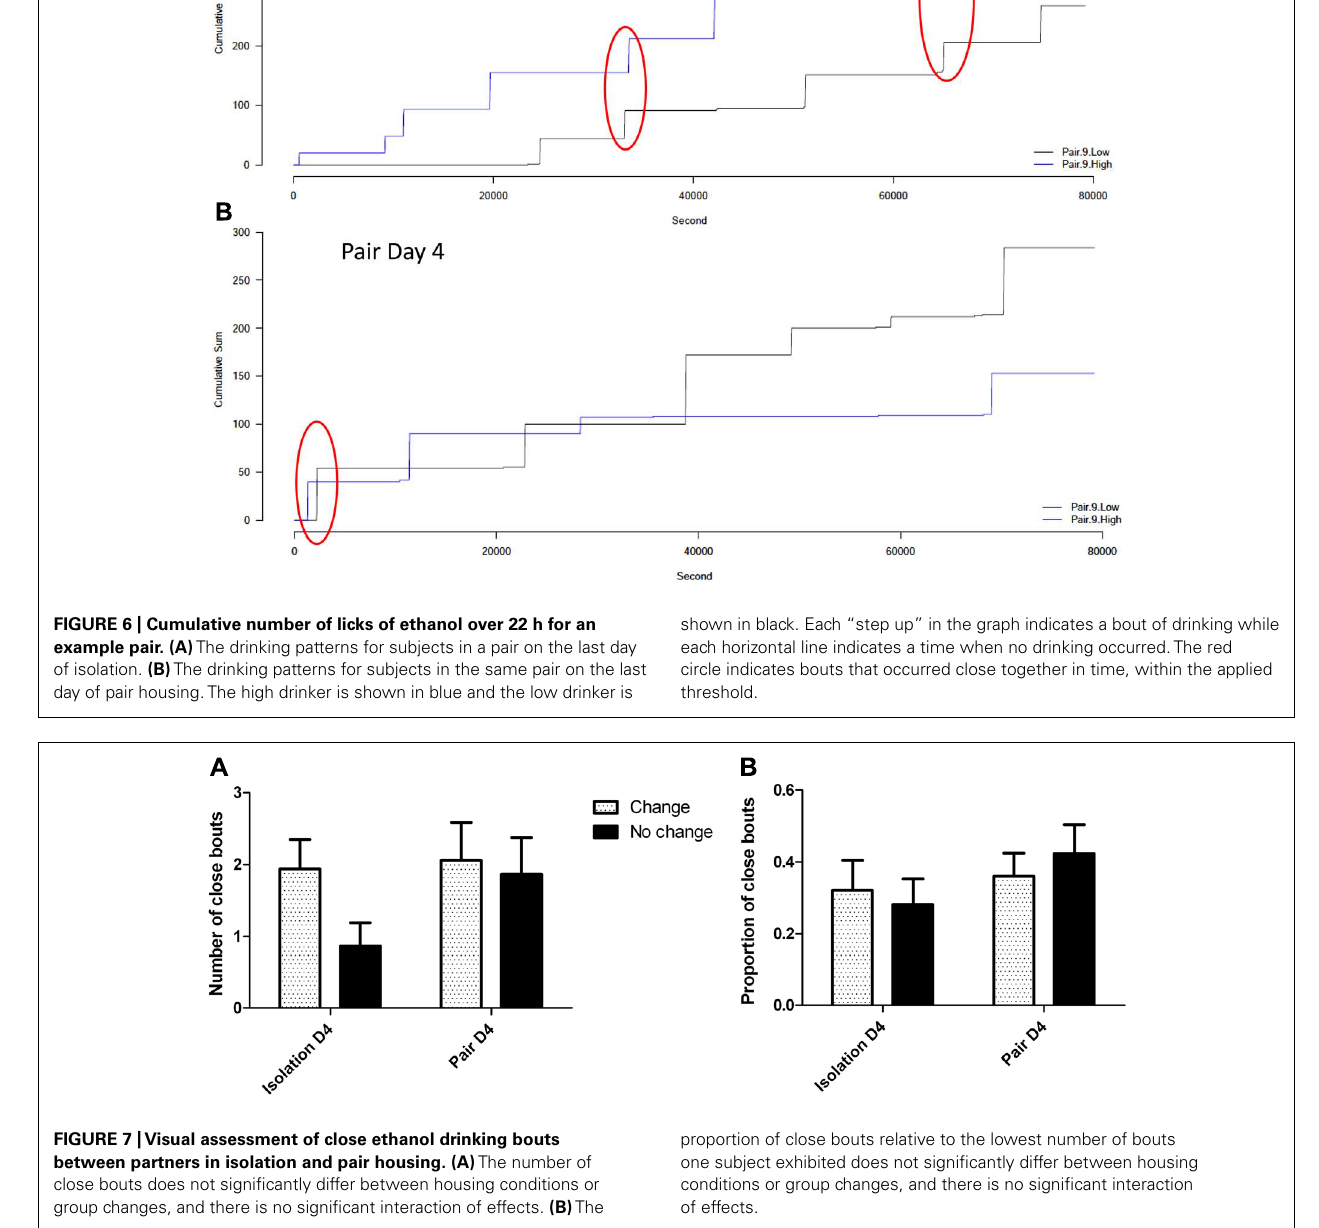
FIGURE 7 |Visual assessment of close ethanol drinking bouts between partners in isolation and pair housing. (A) The number of close bouts does not significantly differ between housing conditions or group changes, and there is no significant interaction of effects. (B) The